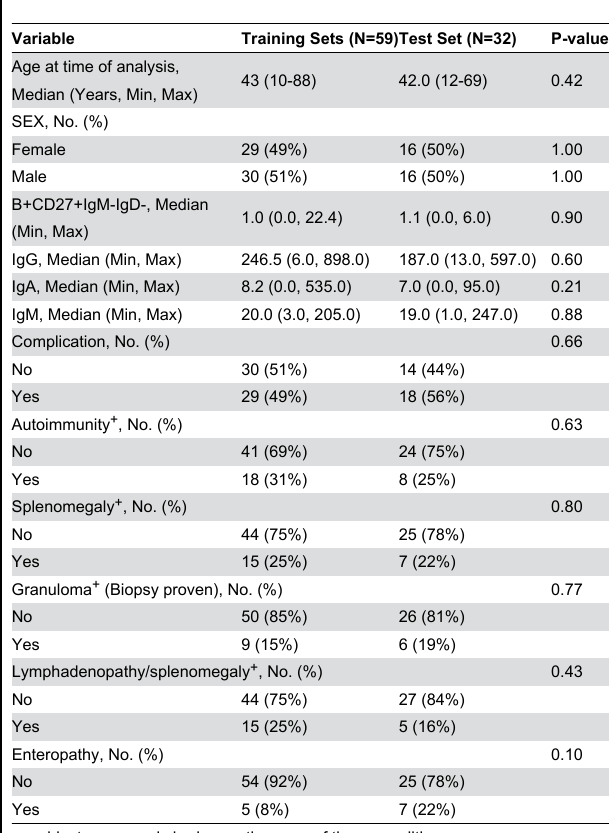
Table 1. Subjects in Training and Test